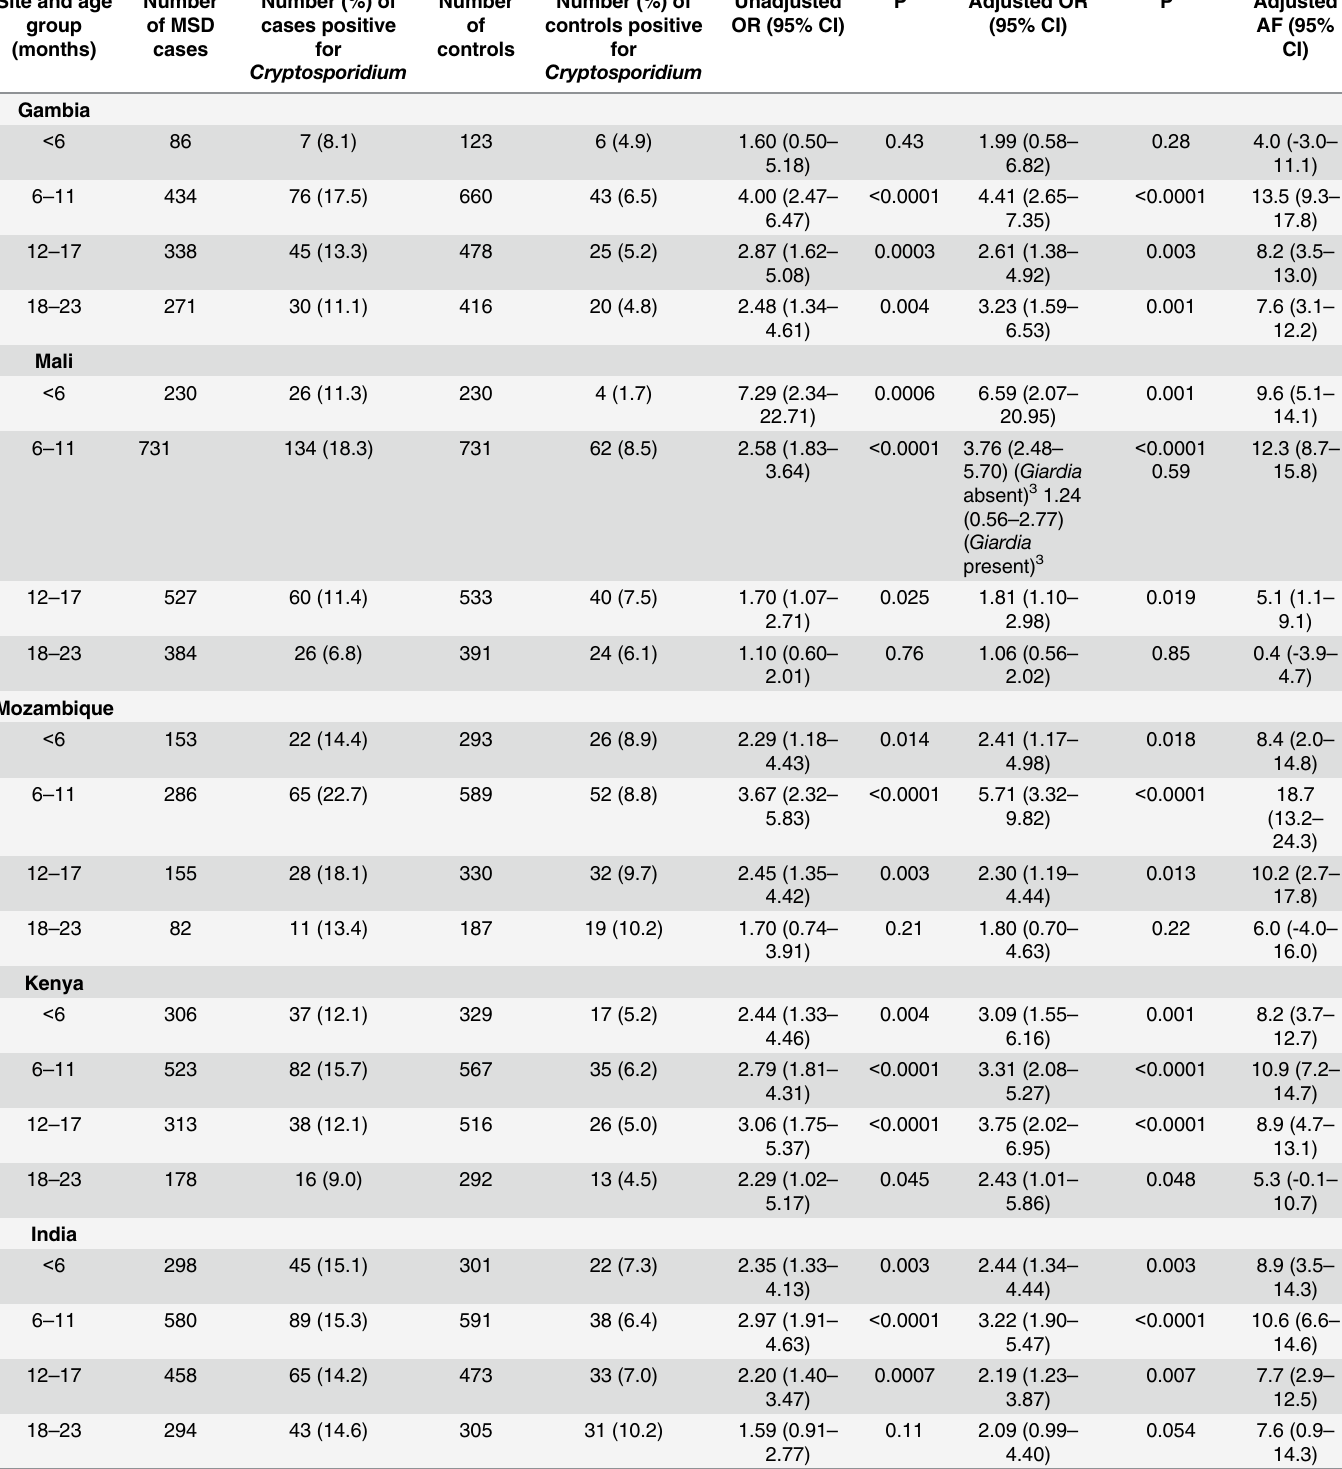
Table 3. Association between Cryptosporidium (by EIA) and MSD from age 0 – 23 months by site during four years of surveillance: matched unad- justed and adjusted odds ratios (ORs) and adjusted attributable fractions (AF) with 95% confidence intervals (CIs) * . Site and age